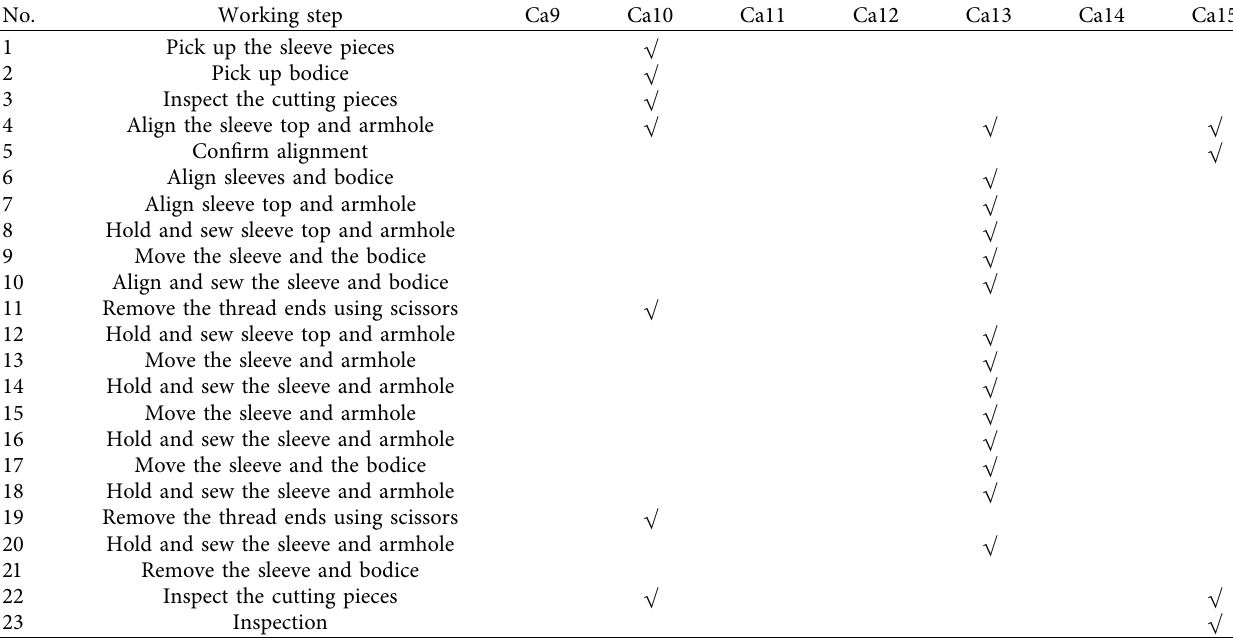
Table 10: Cognitive activities (Ca9-Ca15) of setting in sleeve.